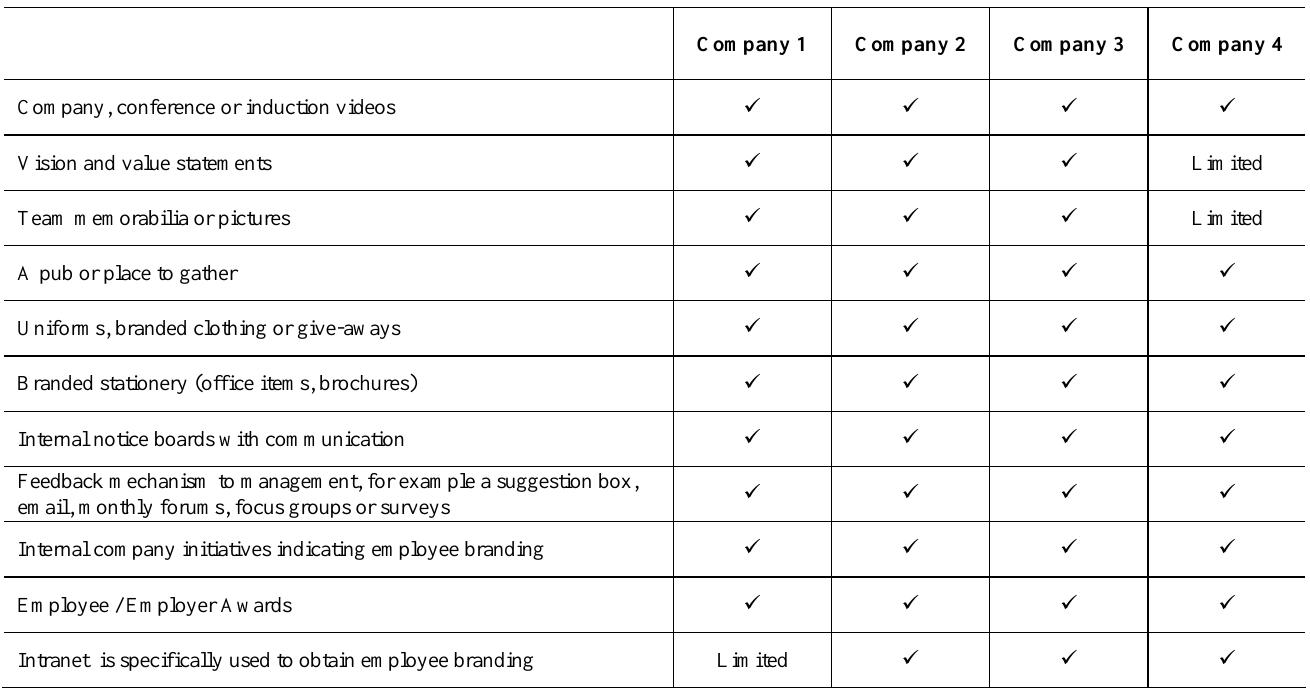
Table 4: Employee branding evidence